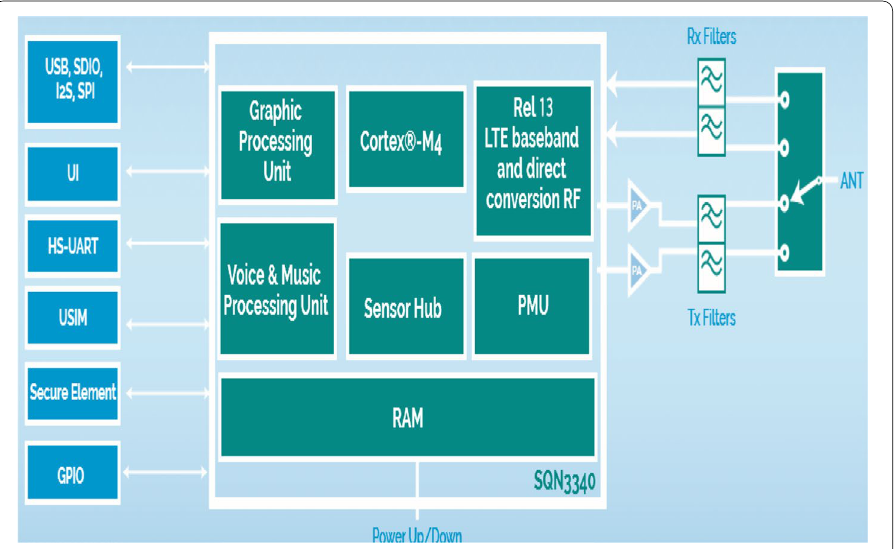
Fig. 1 Different IP cores integrated as part of Monarch SX SoC designed by Sequans